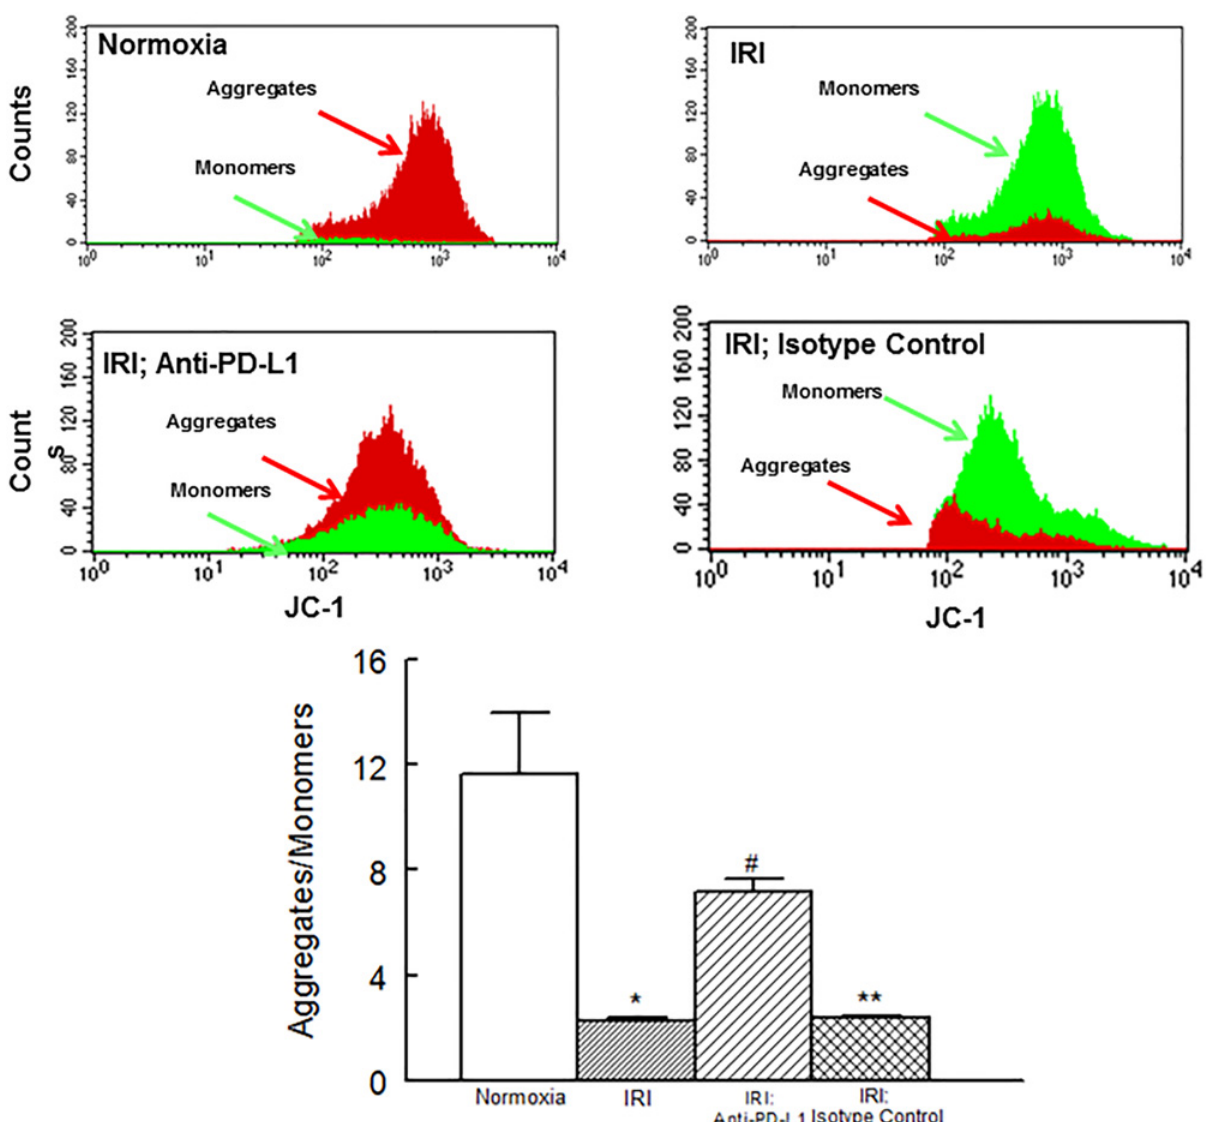
Fig 5. Panels show representative histograms for JC-1 monomers and JC-1 aggregates in cardiac cell preparations while bar graphs show the ratio of JC-1 aggregates to monomers for experimental groups. Data are means ± SEM; n = 6 hearts/group for normoxic control, IRI and IRI; Anti-PD-L1 and n = 4 for IRI; isotype matching control. IRI: Ischemia Reperfusion Injury. * p < 0.05 compared to the normoxic group. ** p < 0.05 compared to normoxia or IRI; Anti-PD-L1 group. # p < 0.05 compared to IRI or IRI; isotype control